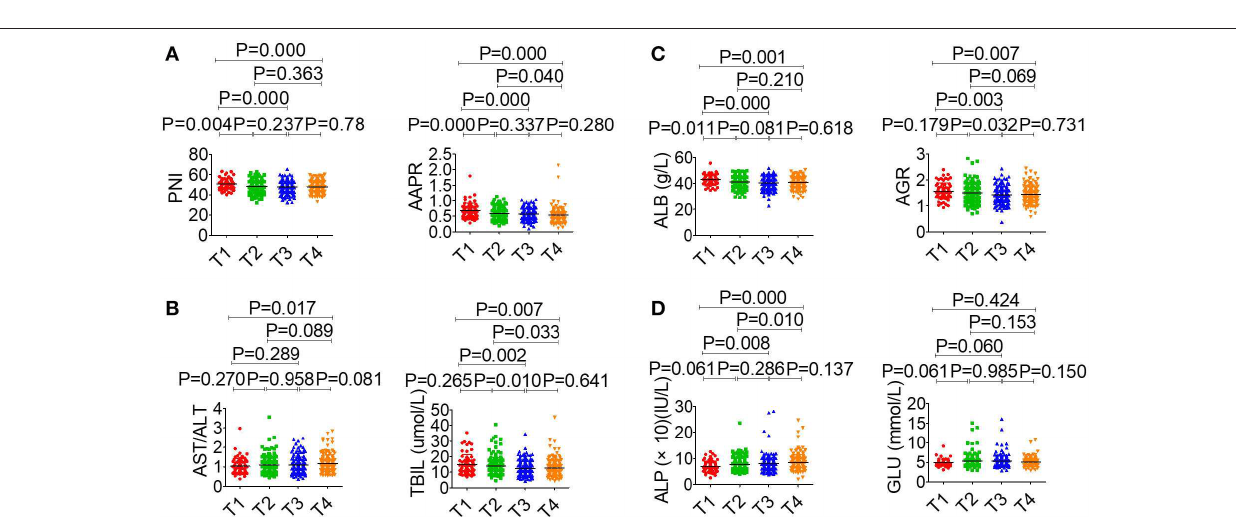
Frontiers in Oncology |